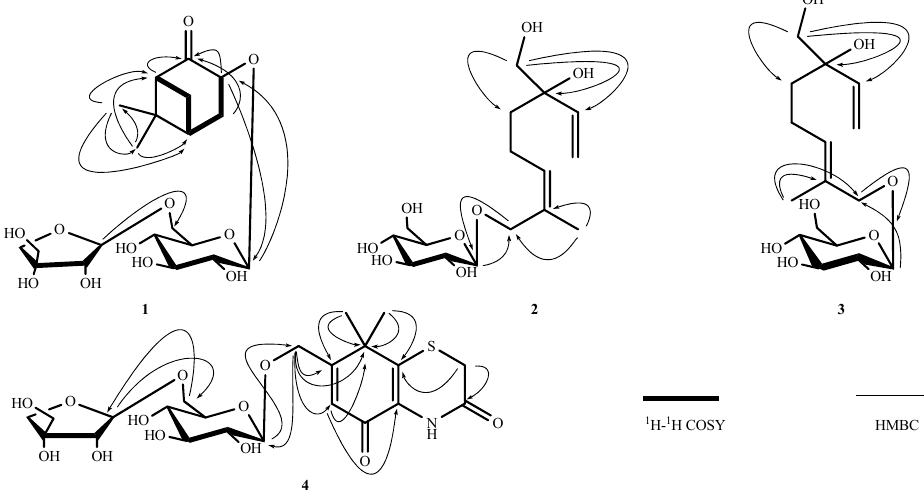
Figure 2. Key 1 H- 1 H COSY and HMBC correlations of compounds 1 – 4